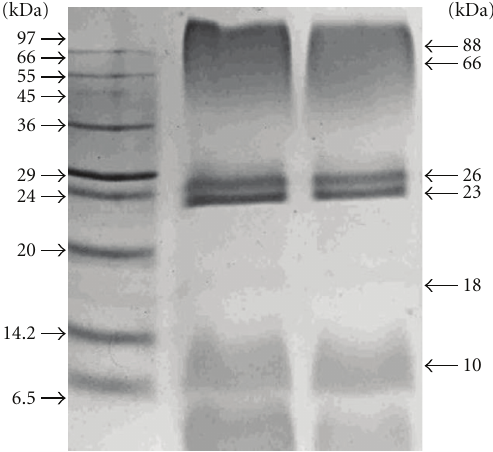
Figure 5: Electrophoretic profiles of OMVs purified from B. melitensis . Lane 1, molecular weight markers; lane 2, OMVs from smooth B. melitensis 16M (80 μ g); lane 3, OMVs from rough B. melitensis VTRM1 (80 μ g). SDS-PAGE gels were stained with Coomassie